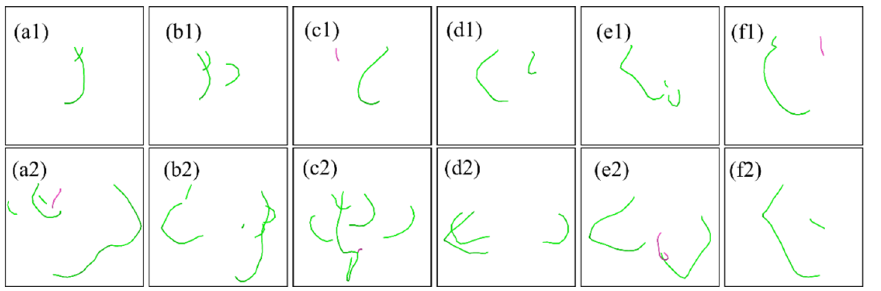
Figure 12. Dislocation line evolutions of five different Zr content under different depths during the indentation process at 1470 K temperature. ( a1 – a2 ) 0 wt.%, ( b1 – b2 ) 1 wt.% ( c1 – c2 ) 2 wt.%, ( d1 – d2 ) 3 wt.%, ( e1 – e2 ) 4 wt.% and ( f1 – f2 ) 5 wt.%, with subscripts 1, 2 standing for 1.5 nm and 2.0 nm, respectively.